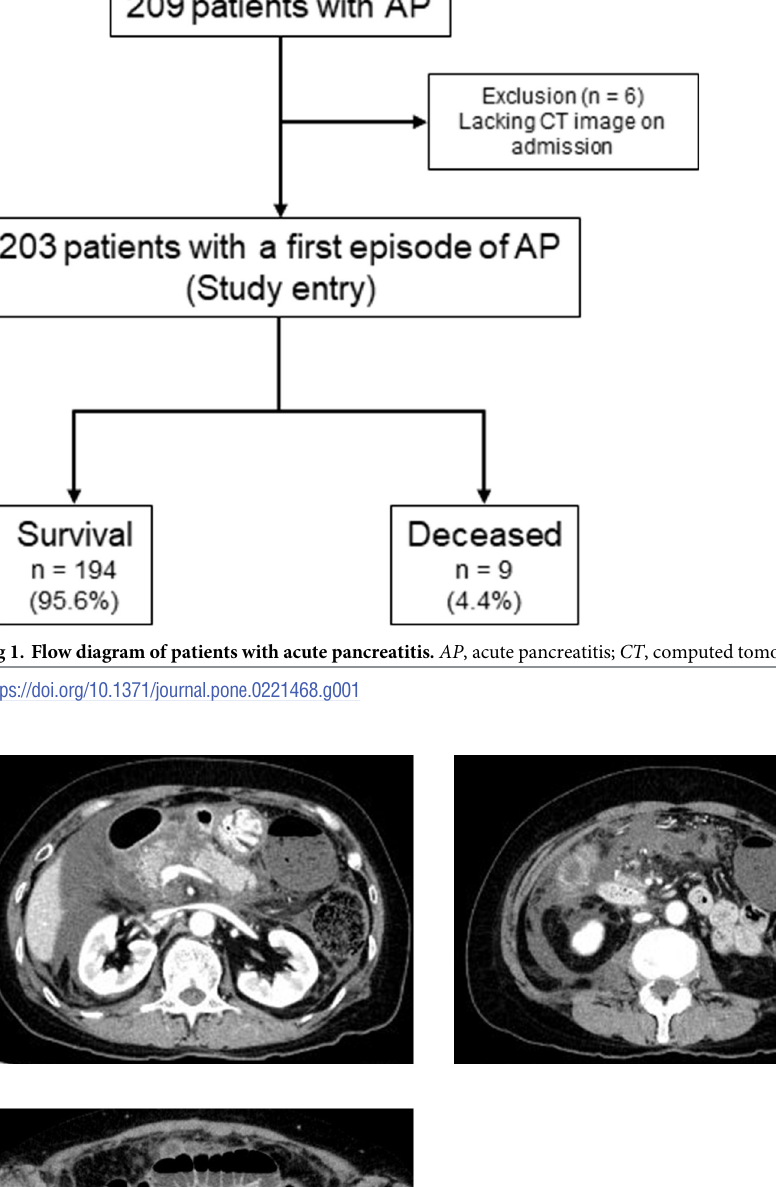
PLOS ONE | https://doi.org/10.1371/journal.pone.0221468 August 22,